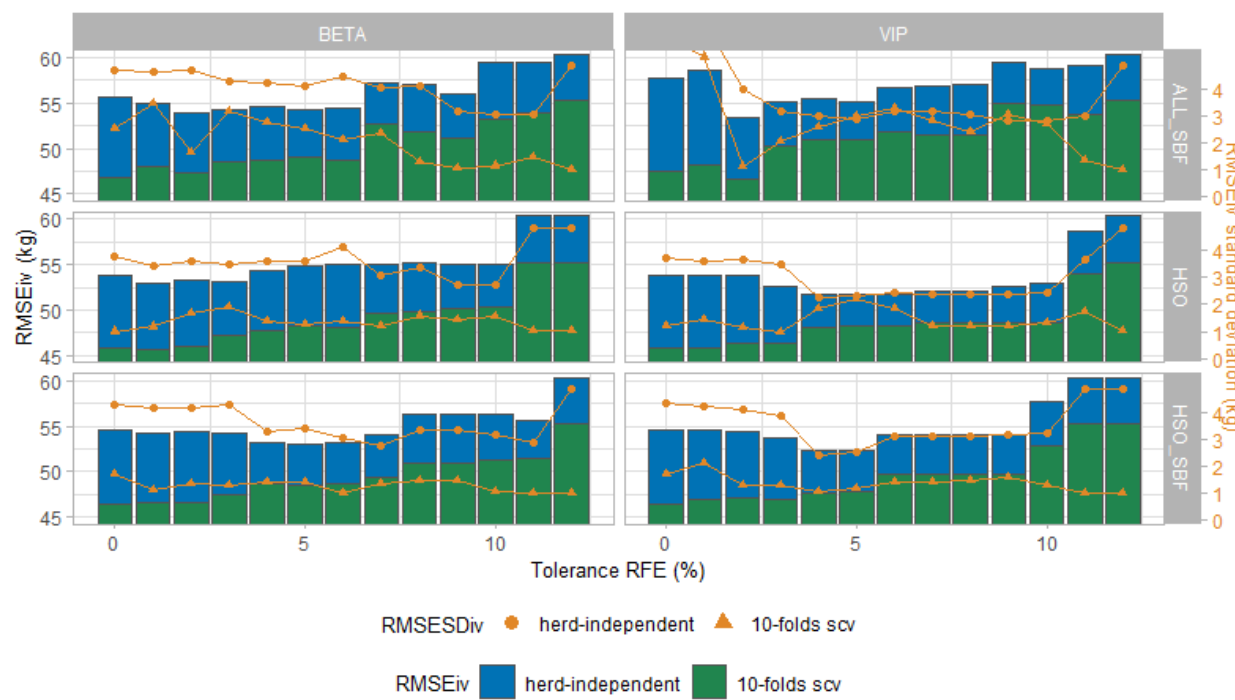
Figure 1. Root mean squared error for herd independent validation repeated 101 times (RMSE iv ) and its standard deviation from the 13 models selected from the recursive feature elimination (RFE) tolerance. RMSE for the stratified 10-fold cross-validation (RMSE SCV ) for the same models and its standard deviation are also plotted.